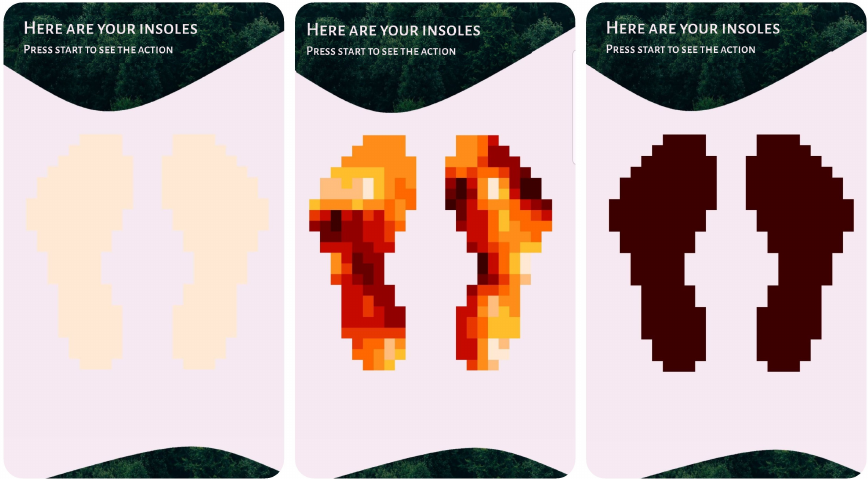
Figure 19. Screenshots from the mobile app with pressure distribution